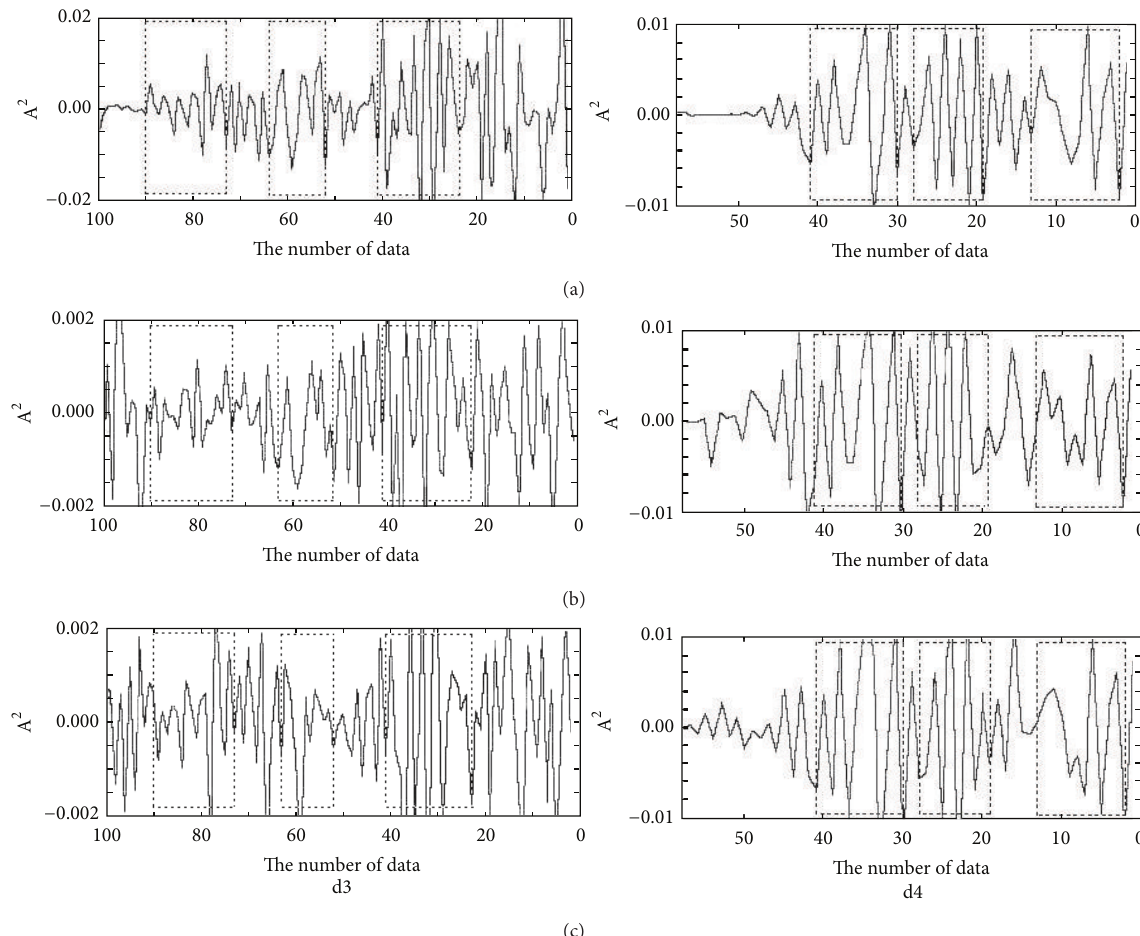
Figure 4: Division of three feature regions of detail signal in DWT domain. (a) Radix Bupleuri ; (b) root of the Bupleurum smithii Wolff; (c) root of the Bupleurum bicaule Helm.